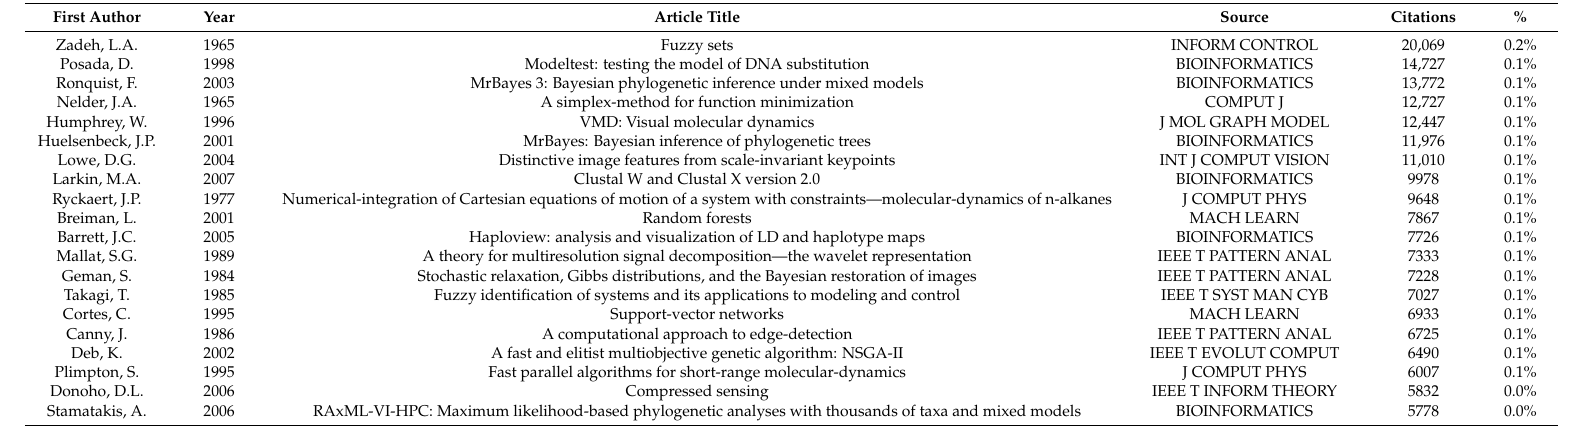
Table 9. Top 20 papers by